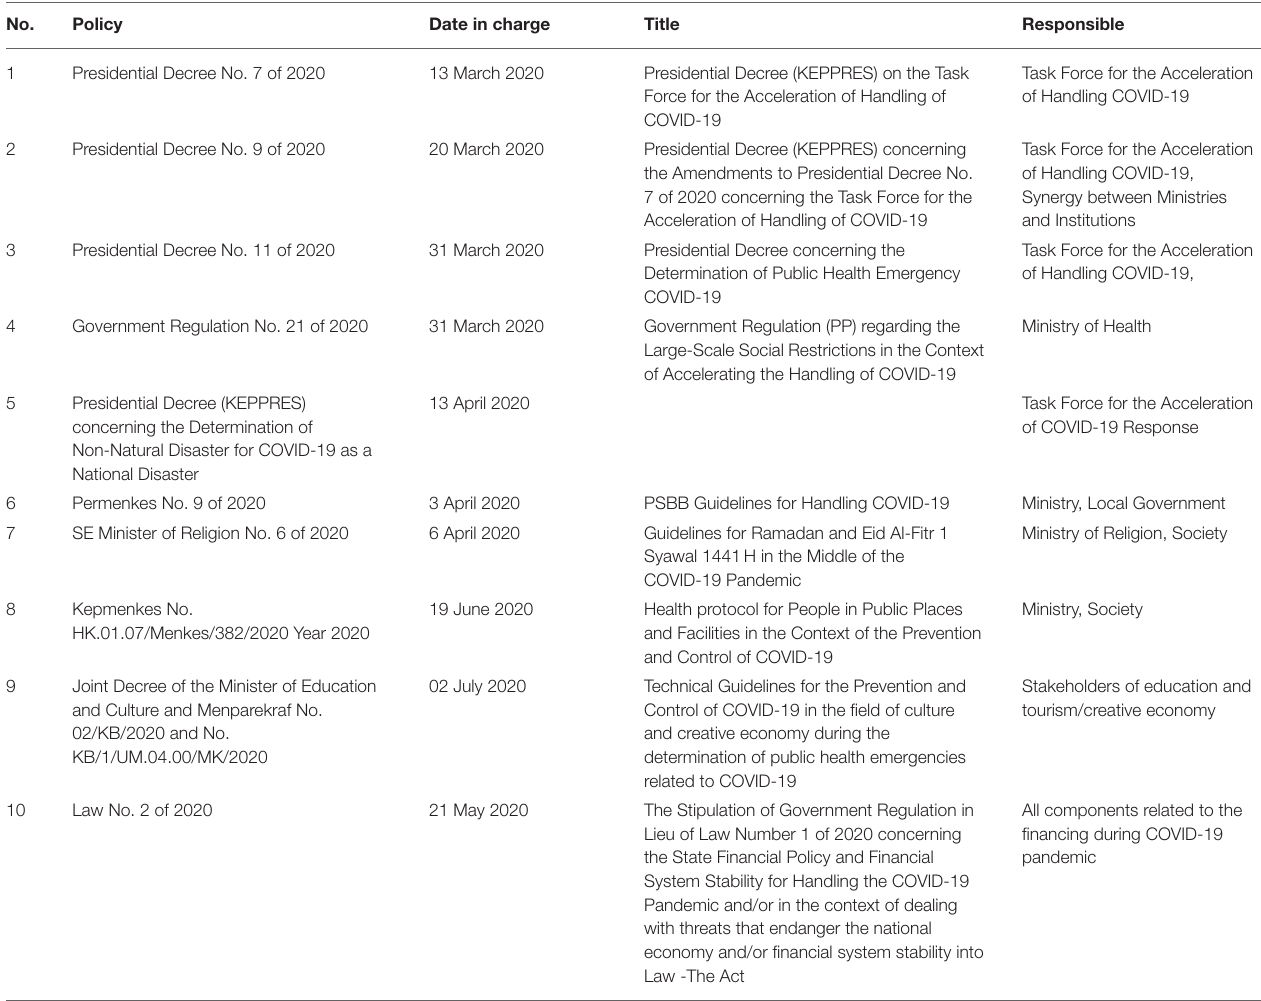
TABLE 2 | Main government policies in facing the COVID-19 pandemic.